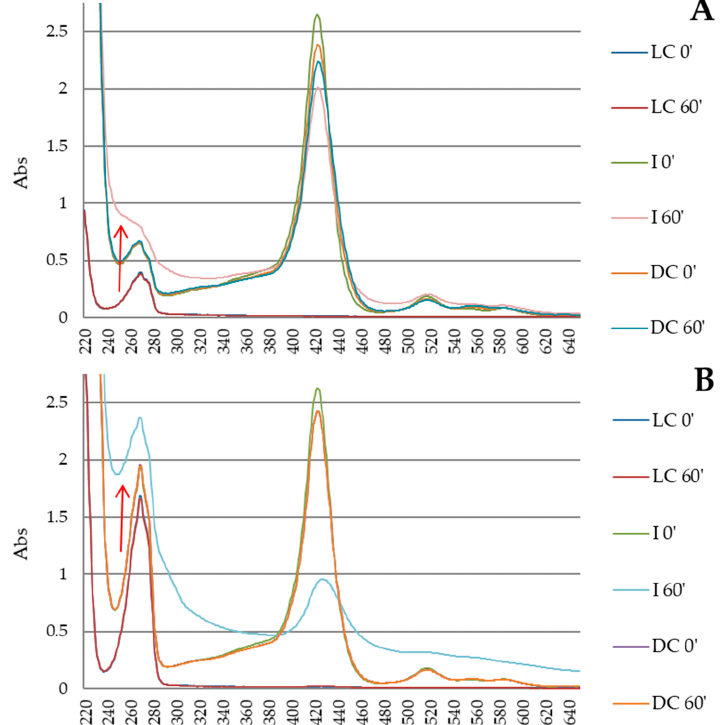
Figure 7. Photodegradation test of phenol at a concentration of 20 mg L − 1 ( A ) and phenol at a concentration of 100 mg L − 1 ( B ) in PBS with solar light with an irradiance between 389 and 1206 W m − 2 and a Tetra-Py + -Me concentration of 25 µ M. These tests of photodegradation had an irradiation period of 60 min. Legend: light control (LC), dark control (DC), and irradiated samples (I) at different times of